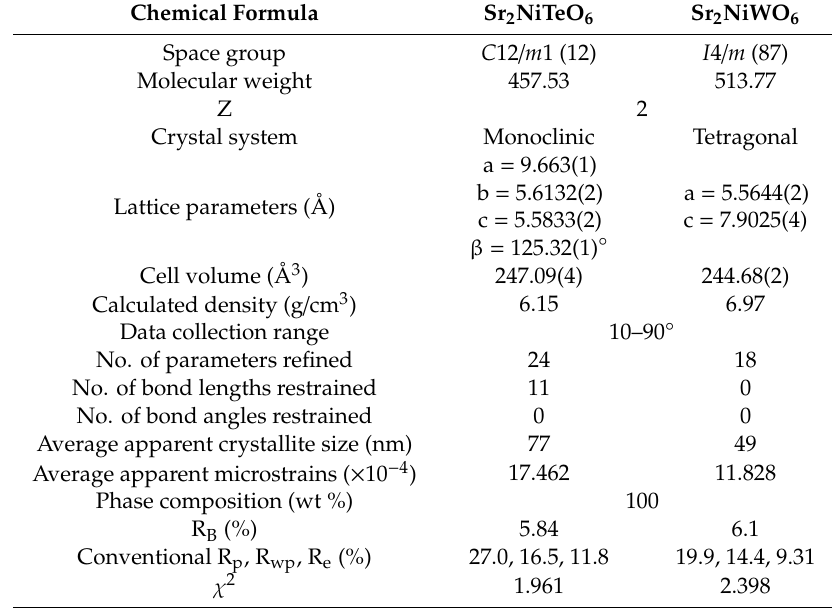
Table 1. Crystallographic data and Rietveld refinement parameters obtained from the XRD patterns of the synthesized compounds.